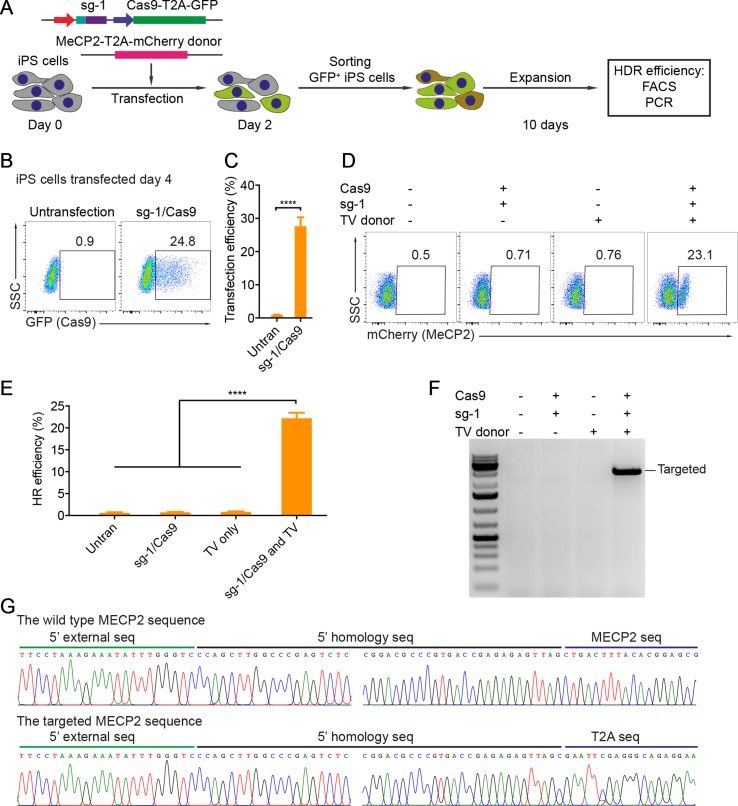
CRISPR/Cas9-mediated reporter insertion in human iPSCs. (A) Experimental scheme of gene editing in human iPSCs. (B) Transfection efficiency in iPSCs using Lipofectamine 3000 was analyzed by FACS. (C) A bar graph indicated the transfection efficiency of human iPSCs, data show means ± SD (****p < 0.0001). (D) FACS analysis showed the knock-in efficiency in human iPSCs represented by the mCherry+ cells. (E) A bar graph showed knock-in efficiencies in human iPSCs, data show means ± SD (****p < 0.0001). (F) Corrected integration PCR and Sanger sequencing data showed the junctions of 5′ HA. The data represent at least two independent experiments.